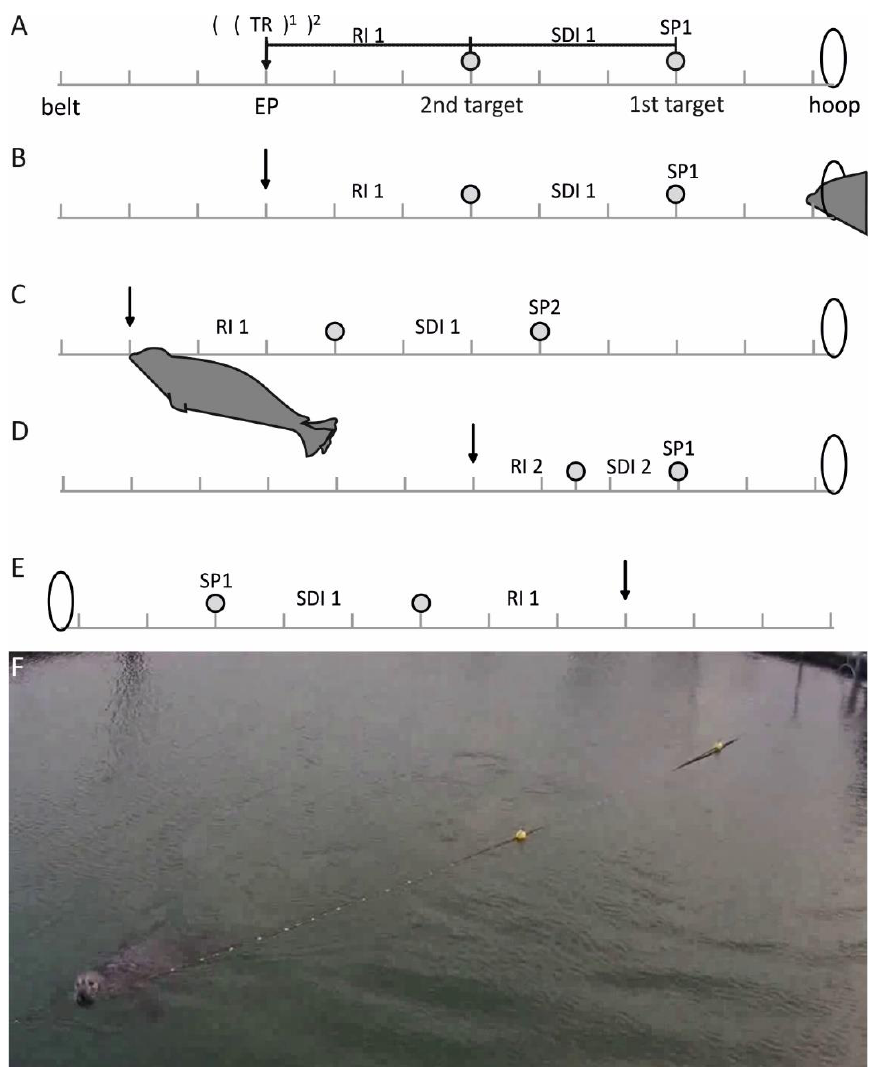
Figure 1. Experimental setup and procedure. ( A ) The basic components of the setup along a belt system are displayed, including a hoop station, in which the seal rested in between trials and two target-balls, the starting point (SP), the standard distance interval (SDI), and the reproduction interval (RI). For differential rewarding, we introduced two tolerance ranges, TR1 and TR2 (see text for explanation). ( B ) The seal started every trial from its hoop station and passed two target-balls, marking the SDI along the belt system. It then had to reproduce the distance presented in the SDI in the RI. The seal was indicating the end of the RI by stationing at the belt; this point is defined as the seal’s endpoint (EP; black arrow). ( B , C ) Throughout the experiment, the SP was varied along the belt and/or ( D ) the distance within the SDI was varied. ( E ) After the testing phases in stages 1 to 4 of experiment 1, we conducted a control session in which the animal had to perform the task in the opposite swimming direction. ( F ) Image of the camera recording the experimental trials. The seal has passed the two target balls, has reproduced the distance presented in the SDI (here: a 3 m distance was presented) and now indicates its decision by resting at the